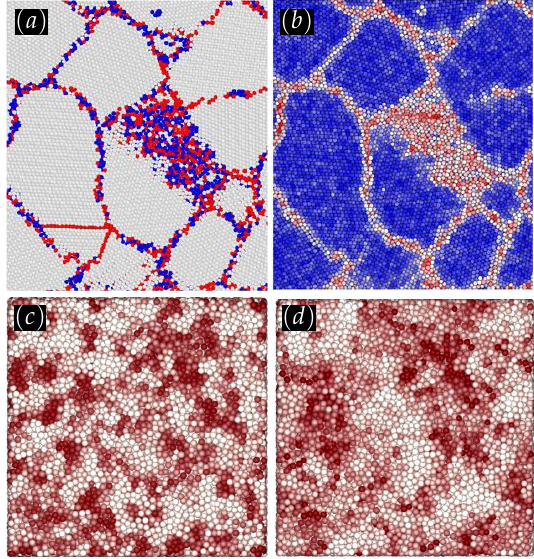
Figure 6. Linking microstructure with dynamics. ( a ) Distinct microstructures (bulk grains versus grain boundaries) illustrated based on the Voronoi topology analysis of a simulated polycrystalline aluminum. The white, red, and blue colors denote the FCC phase, hexagonal close-packed (HCP) structure, and atoms with neither the former nor the latter structure, respectively. ( b ) The same snapshot displaying the associated softness (reproduced from [42]). Atoms with a high softness are red and those with a low softness are blue. ( c ) Binary microstructural classification of particles in a model glass former colored according to the probability of being a member of the corresponding cluster. Dark red and white denote high and low probabilities. ( d ) The same particles but color-coded in accordance with the associated mobility. Dark red and white indicate high and low mobility (reproduced from [106] licensed under CC BY